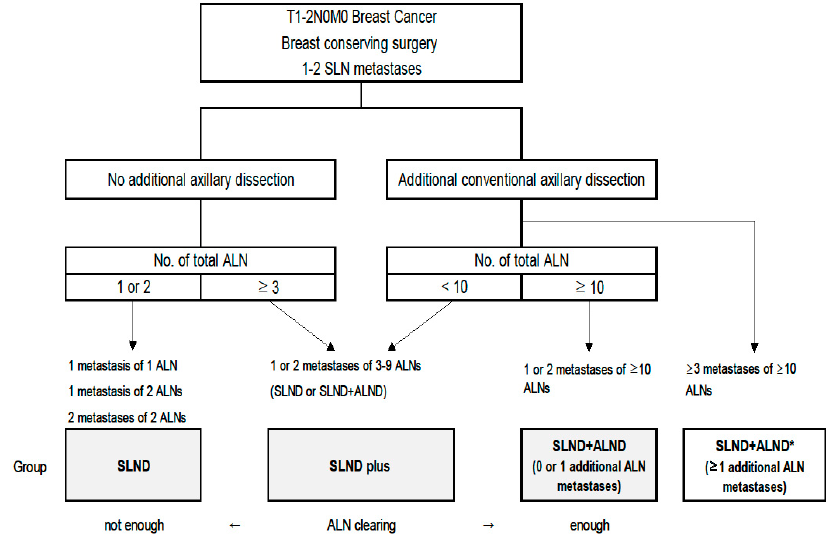
Figure 5. Assumed decision flow for patients who were eligible to the Z0011 strategy. Abbreviations: axillary lymph node (ALN); axillary lymph node dissection (ALND); sentinel lymph node (SLN); sentinel lymph node dissection (SLND). * Patients who had ≥ 3 metastases were not included in this study.